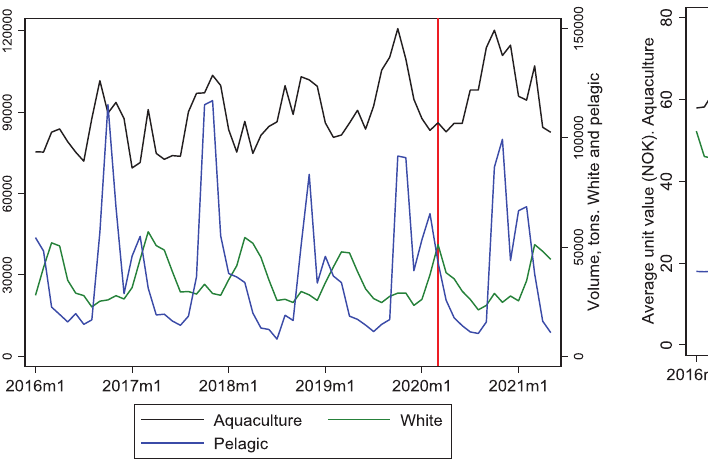
Fig. 2. Monthly export quantity. January 2016 – May 2021.